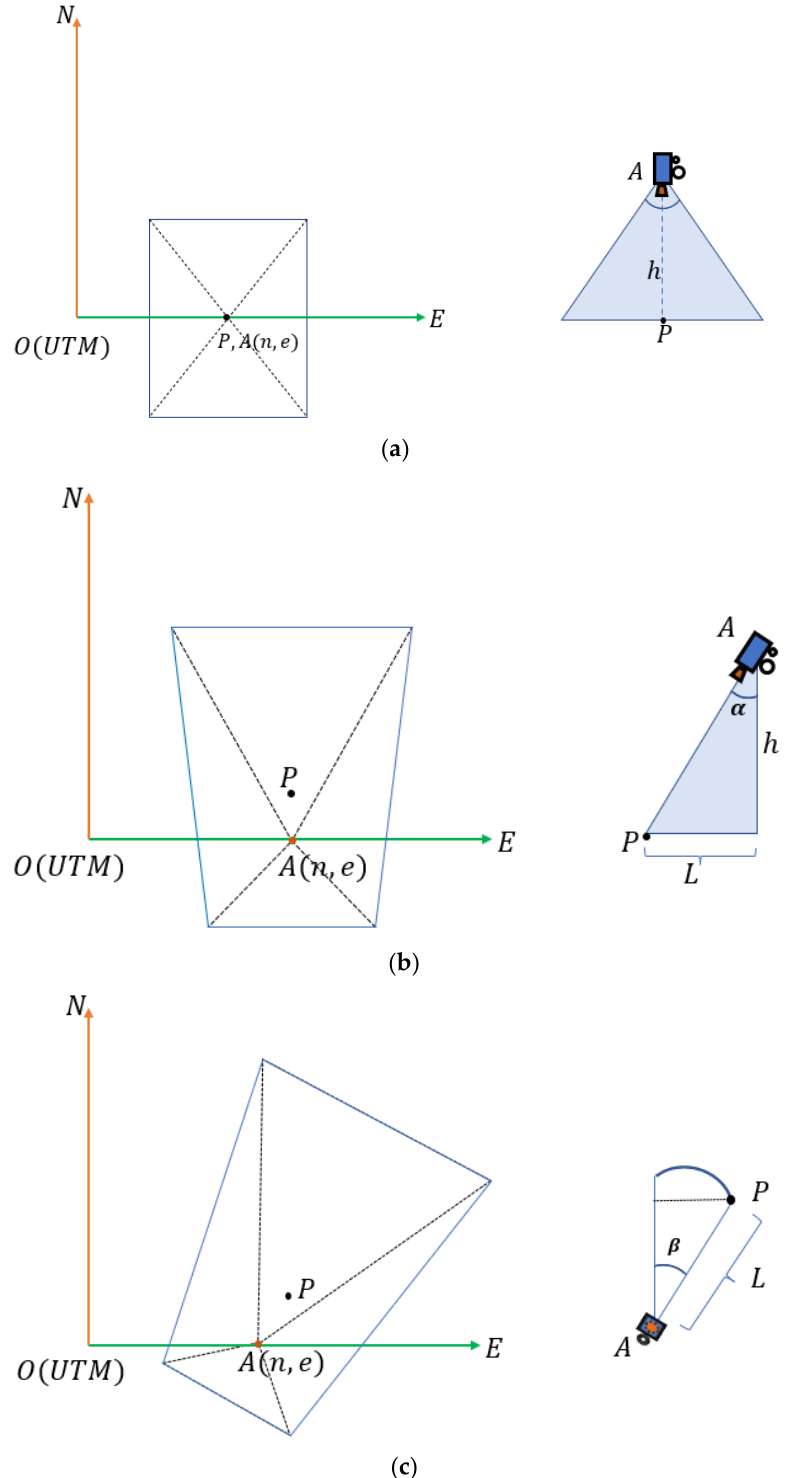
Figure 7. Top view of the camera ’ s field-of-view. 𝐴(𝑛, 𝑒) represents the camera position and coordinates, 𝑃 represents the center point of the camera image, ℎ is the altitude of the UAV, and 𝐿 represents the displacement of 𝑃 when the camera rotates up and down. ( a ) Camera without rotation; ( b ) camera is rotated up and down by 𝛼 degree; ( c ) camera is rotated up and down by 𝛼 degrees and left and right by 𝛽 degrees.